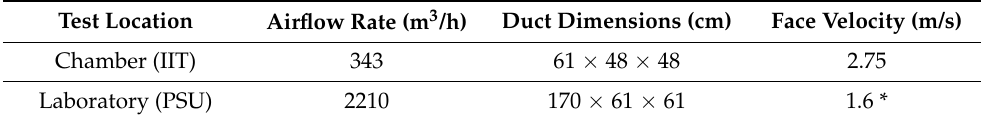
Table 1. Summary of electronic air cleaner (EAC) installation details at each test